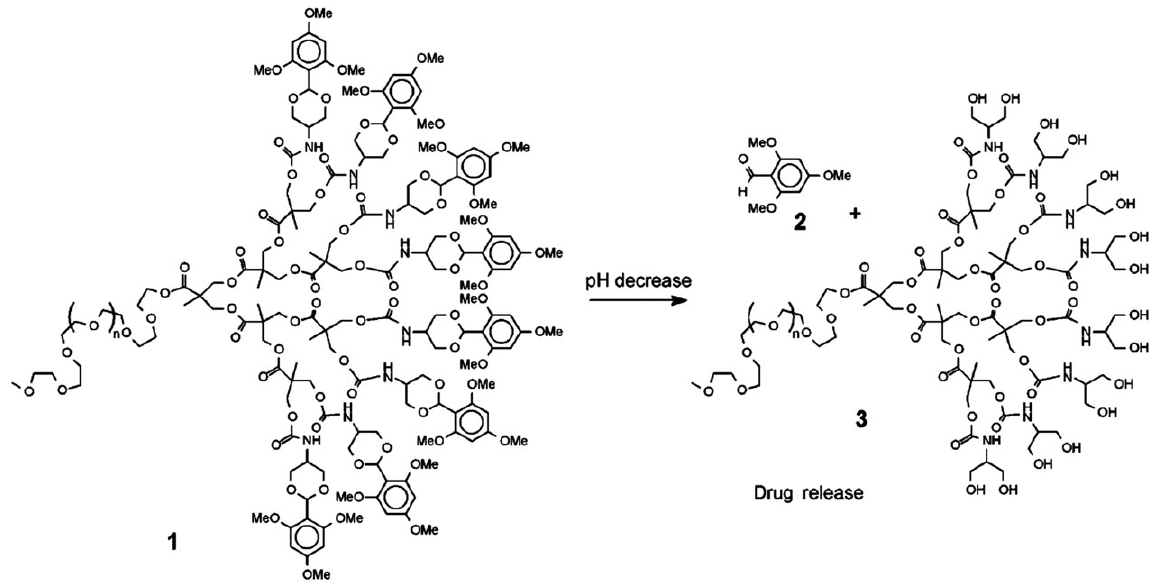
Figure 6 Scheme of acetal hydrolysis for acid-responsive dendritic micelles [33] . Reprinted with permission from Ref. [33] . Copyright (2005) American Chemical